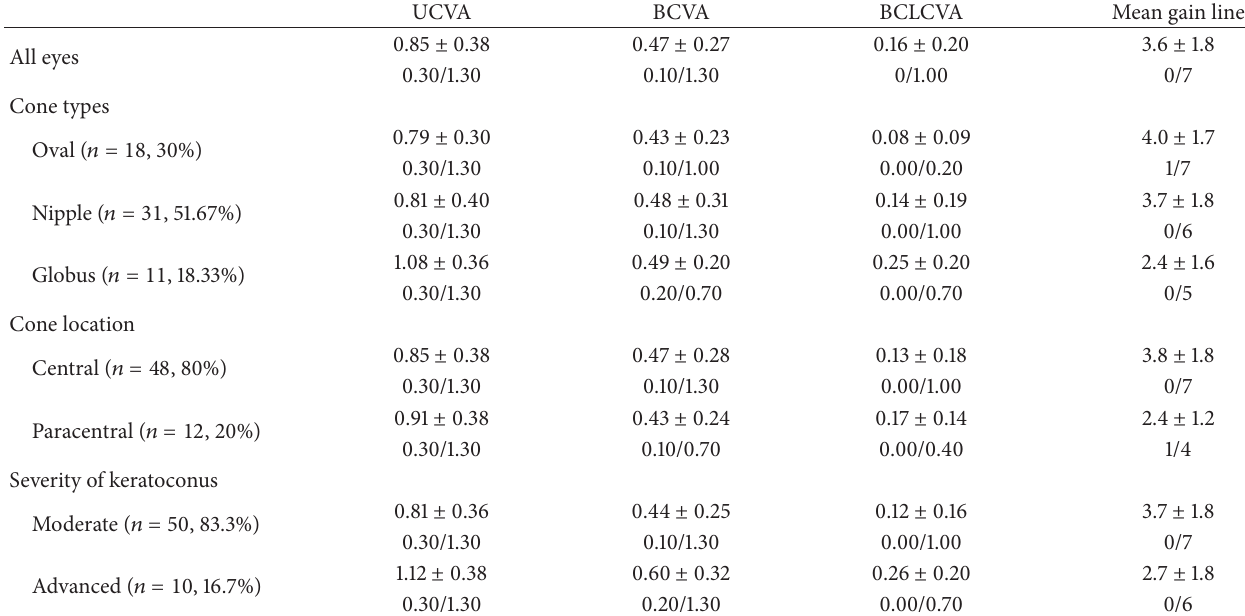
Table 3: Visual acuity (logMAR, mean ± sd, min./max.).